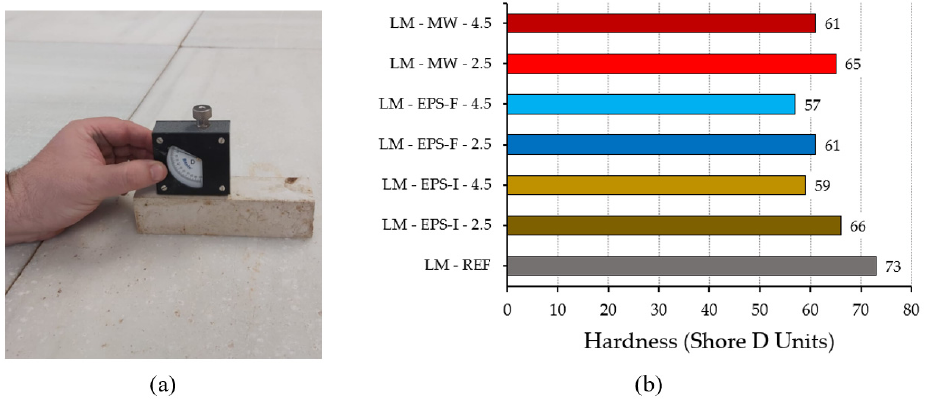
Figure 8. Surface hardness. ( a ) Taking measurements with a Shore D Durometer; ( b ) results obtained for the different mortars.